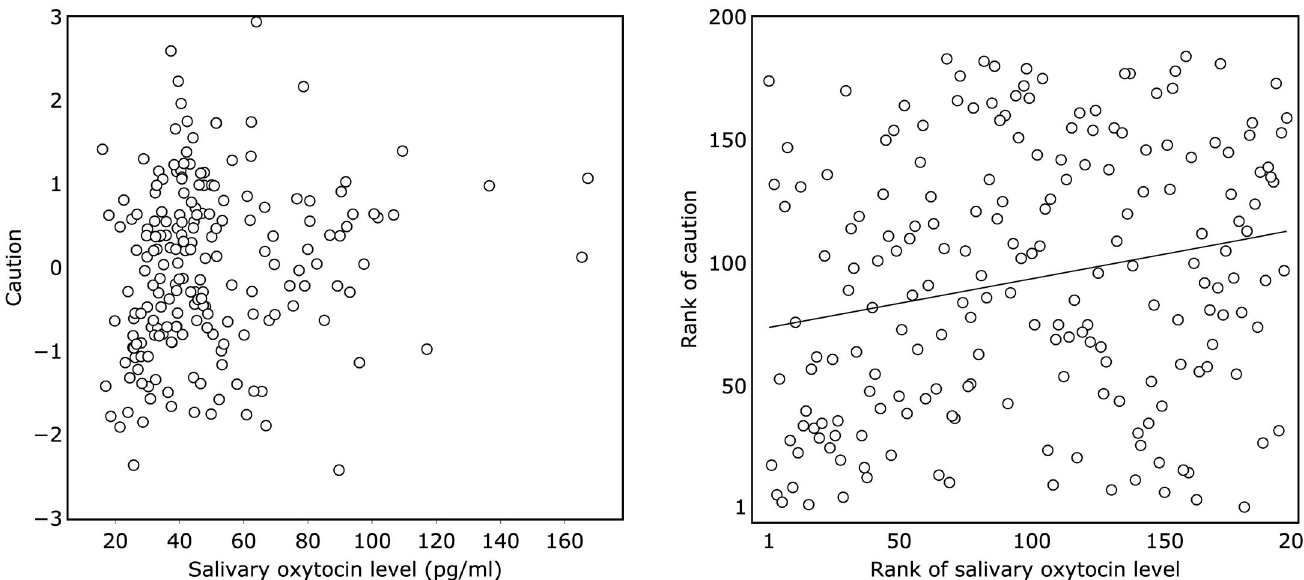
Fig 1. The association between salivary oxytocin level and caution. (A) scatter plot of salivary oxytocin level and caution. (B) scatter plot of rank of salivary oxytocin and rank of caution.